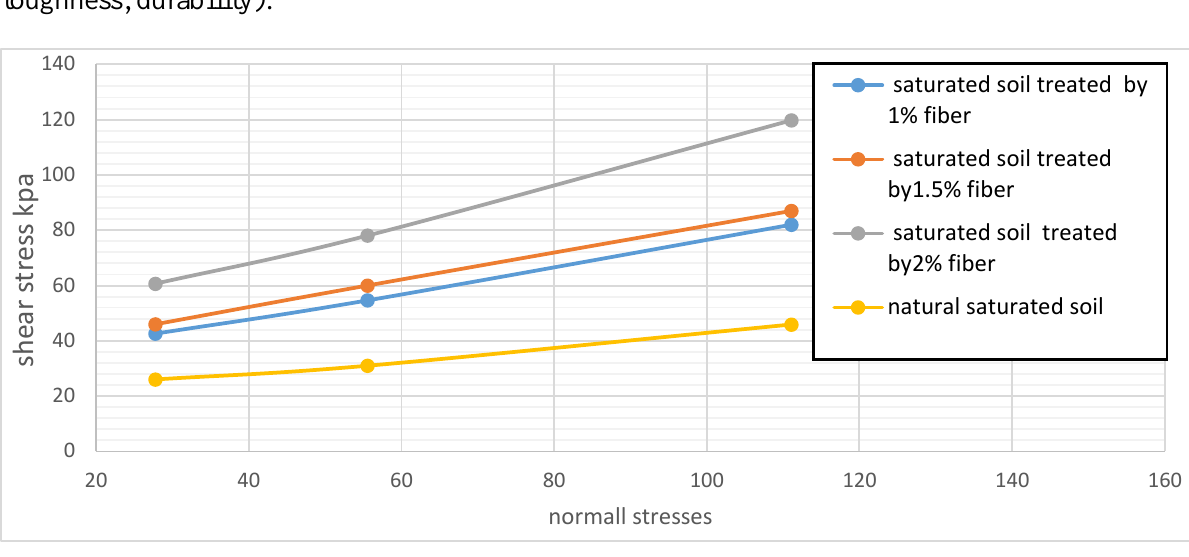
Fig. 10. Relationship between normal stresses and shear stress for treated soil with PPF, from direct shear test in soaked